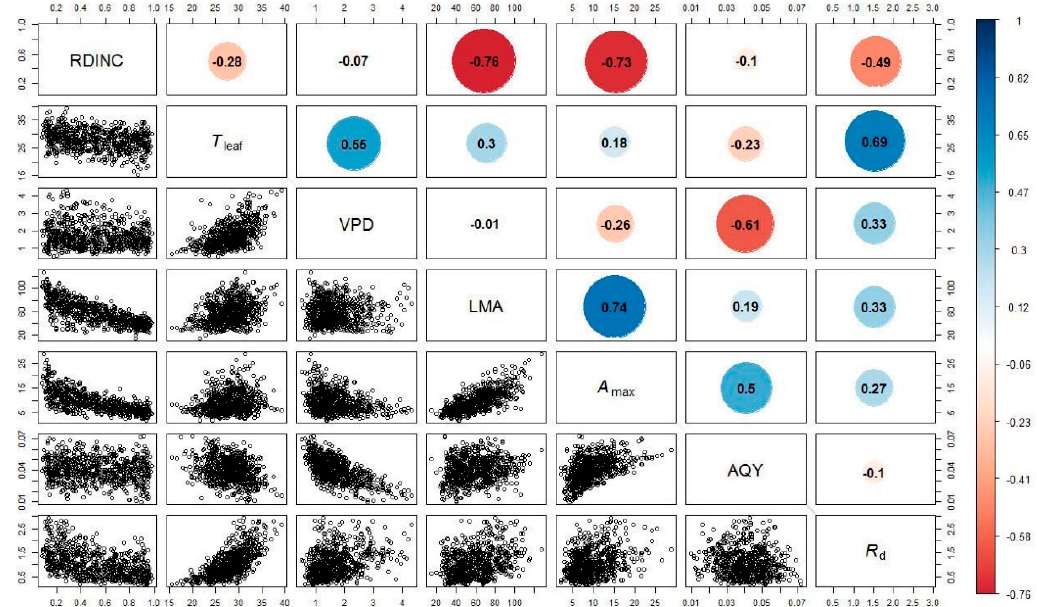
µ mol m − 2 s − 1 ) for d ,